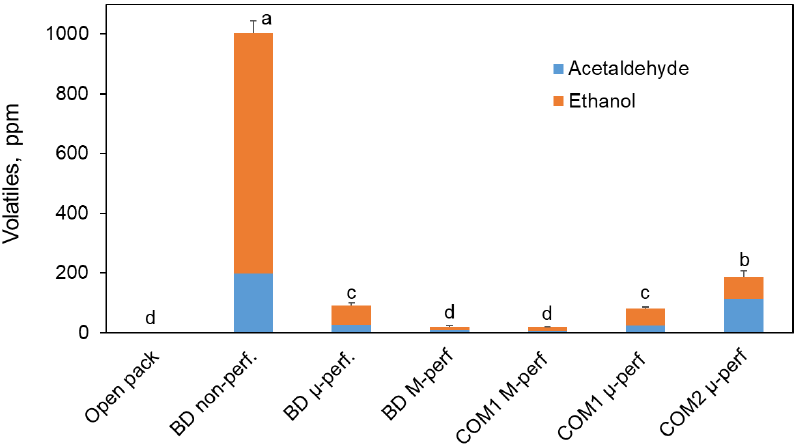
Figure 3. Accumulation of acetaldehyde and ethanol vapors (fermentation volatiles) in the headspace of banana packages after 3 days of simulated distribution at 15 °C and 5 days of shelf life/home storage at 24 °C. Package designations are the same as in Figure 2. Error bars represent standard errors of three replications. Different letters above the bars indicate significant differences at p ≤ 0.05 according to Tukey’s HSD test.